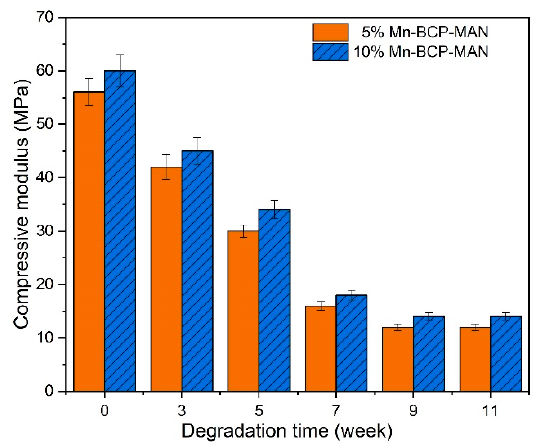
Figure 5. Compressive modulus of the scaffolds.